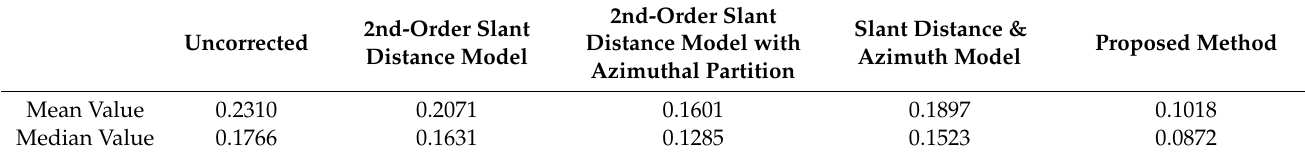
Table 3. The statistical results of the residual AP’s standard deviation after APC.